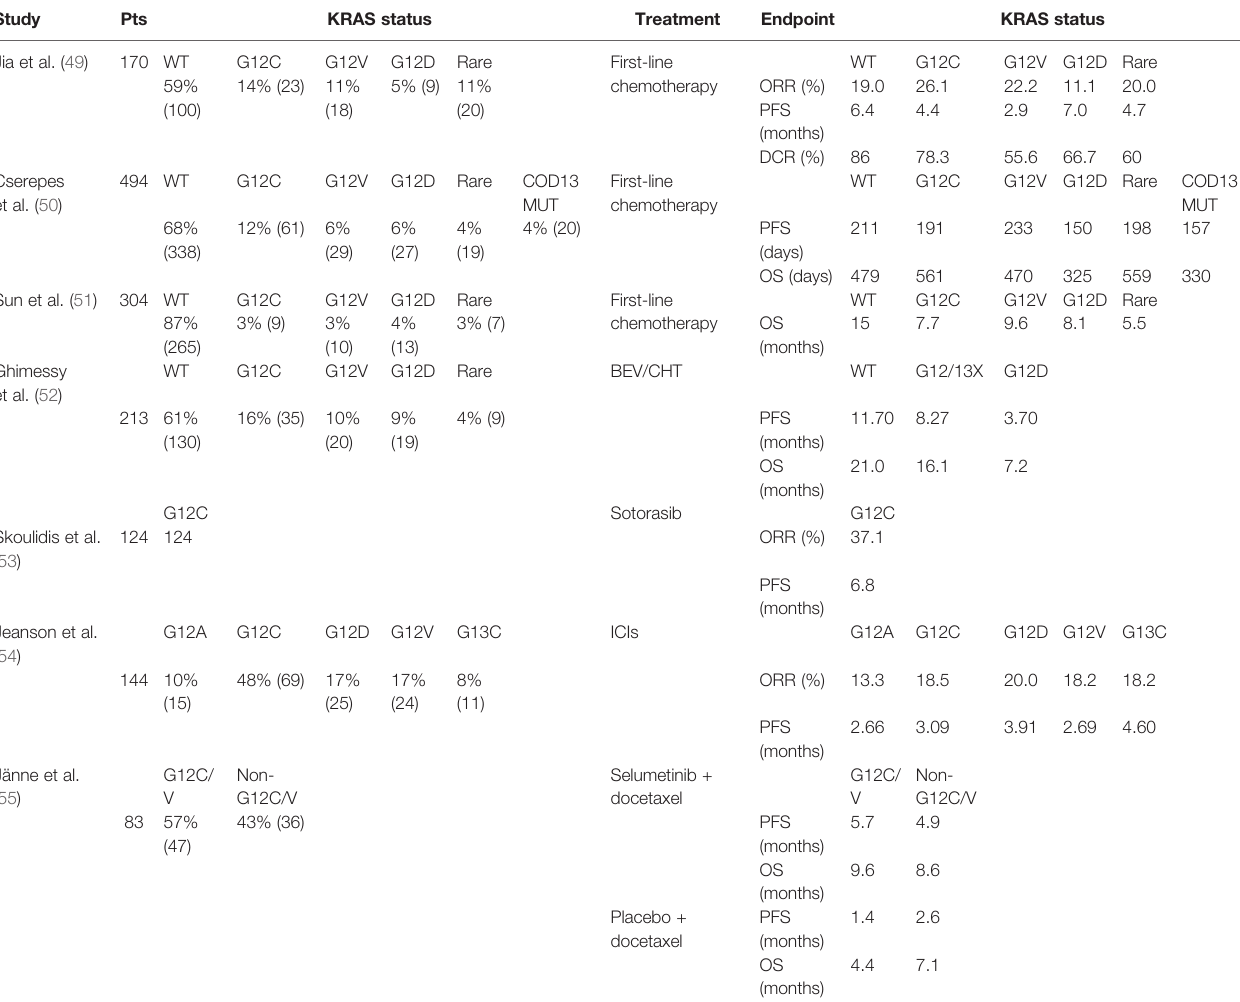
TABLE 1 | Summary of clinical trials investigating the outcome of different KRAS mutation subtypes. Study